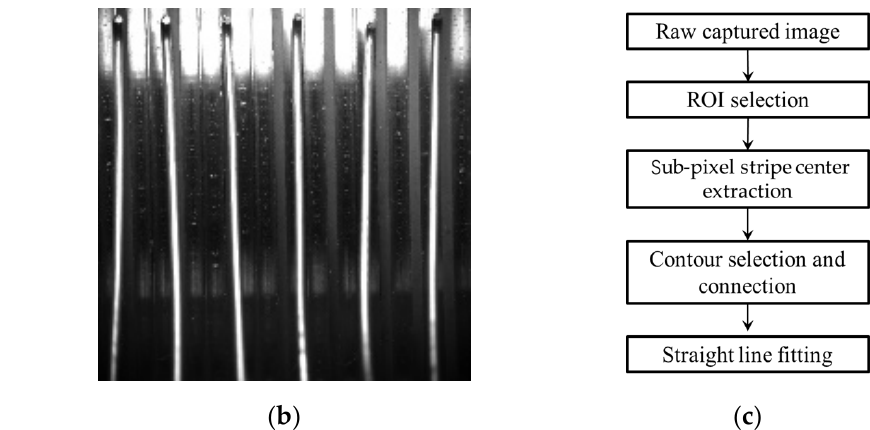
Figure 6. Vision tracking of brush position: ( a ) Light projection; ( b ) Brush image; ( c ) Flow diagram of the image processing to track the brushes.